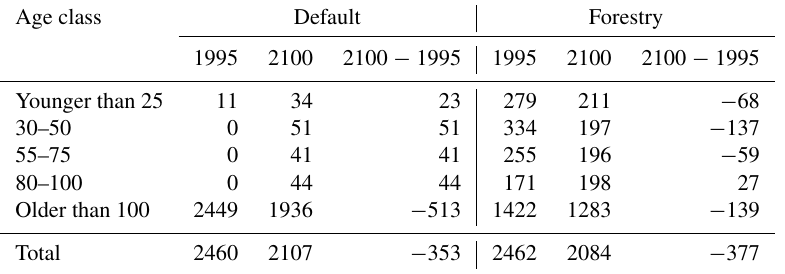
Table 4. Difference in secondary forest area between 1995 and 2100 (Mha).